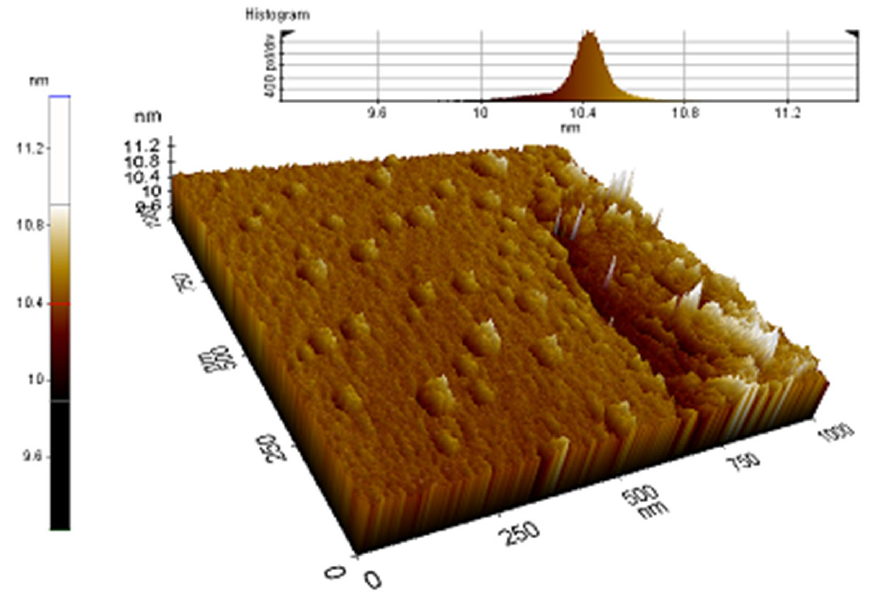
Figure 7. AFM spectra of TiO 2 -FG/Sr-hexaferrites. Photocatalytic Decolorization of Rh. B and MB Dyes Two organic dyes, rhodamine B (Rh. B) and methylene blue (MB), were catalytically decomposed by the nanocomposite as prepared under the effect of visible light in order